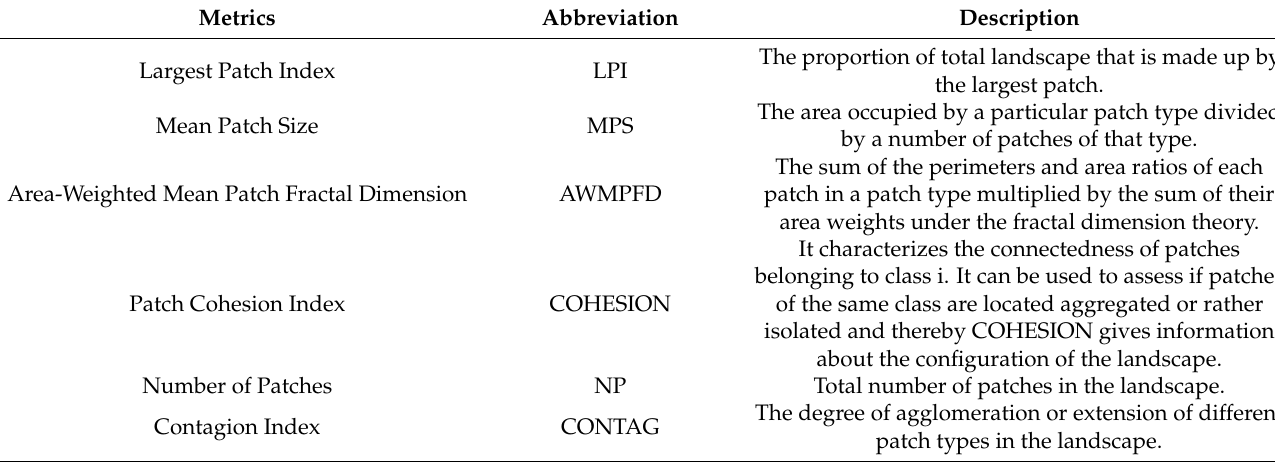
Table 3. Spatial metrics selected in this